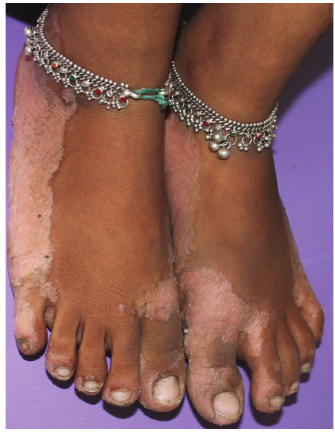
Figure 3: Peeling off of the skin over the